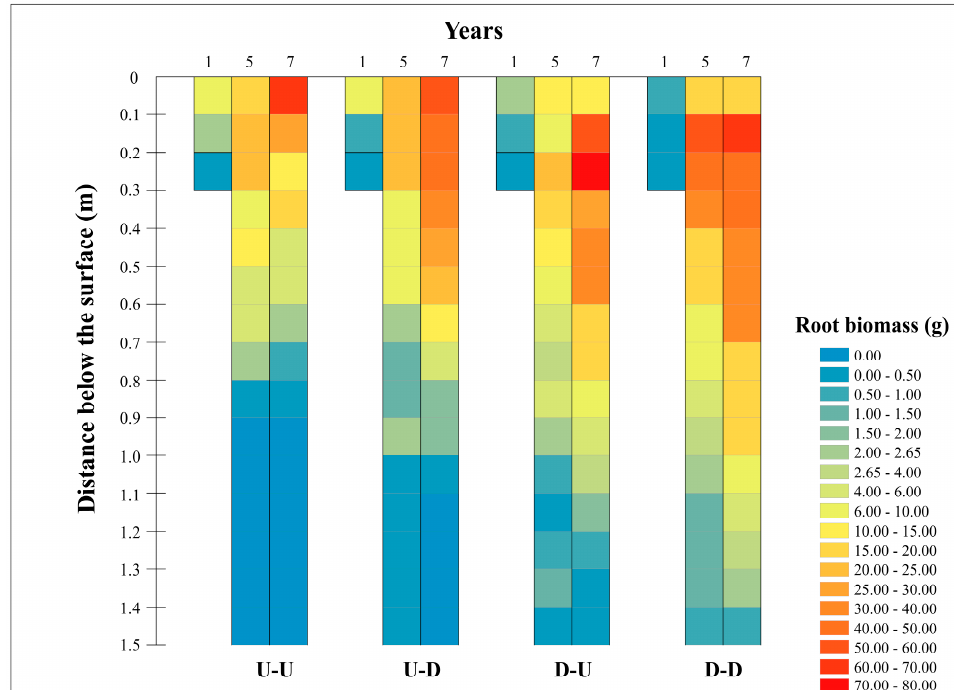
Figure 6. Spatio-temporal distribution of root biomass with depth in every unit. U-U, D-U, U-D and D-D represent the upslope-upstream face, the downslope-upstream face, the upslope-downstream face and the downslope-downstream face of the sample, respectively. Each color block represents the range of root biomass in each test unit. The value of each color block is the arithmetic mean corresponds of the 5 morphological research objects at each age.